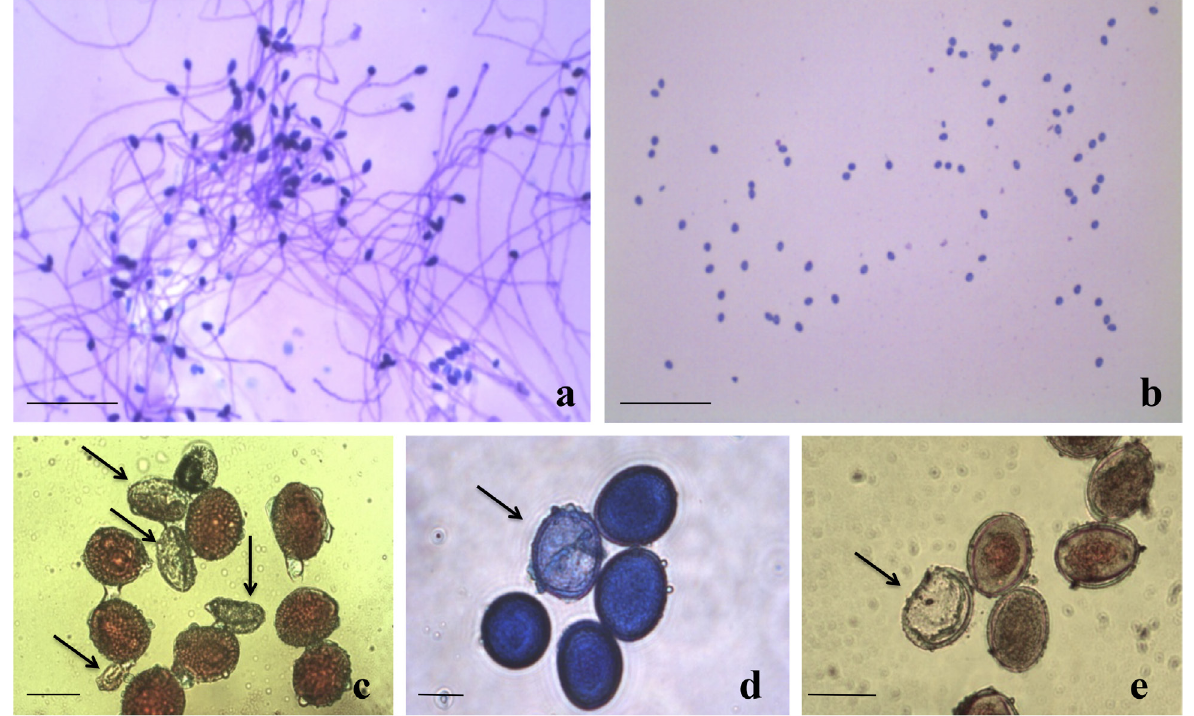
Figure 4 - In vitro germination and histochemical test of Bromeliaceae pollen grains. a-b ) Pollen germination of Bromeliaceae species. a ) Ae. fasciata in BKM medium, showing greater pollen tube length; b ) Aechmea bicolor in BM medium, showing lack of pollen germination; c-e ) Viability by histochemical test of pollen. c ) Ae. fasciata pollen stained with acetocarmine (1%); d ) Ae. nudicaulis pollen stained with Alexander’s solution plus 2% lactic acid; e ) Ae. distichantha pollen stained with Sudan IV (1%). (arrows = unviable pollen). BM (Parton et al. 2002), BKM (Brewbaker and Kwack 1963). Bars: a-b = 0.5 mm; c, e = 50 µm; d = 20